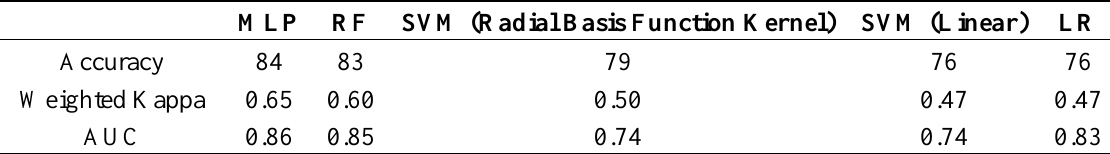
Table 4. Classification accuracies (%), Weighted Kappas and area under the receiver operating characteristics curve (AUCs) of different classifiers trained to distinguish between bradykinesia and dyskinesia. All scores were estimated with a stratified 10-fold cross-validation.